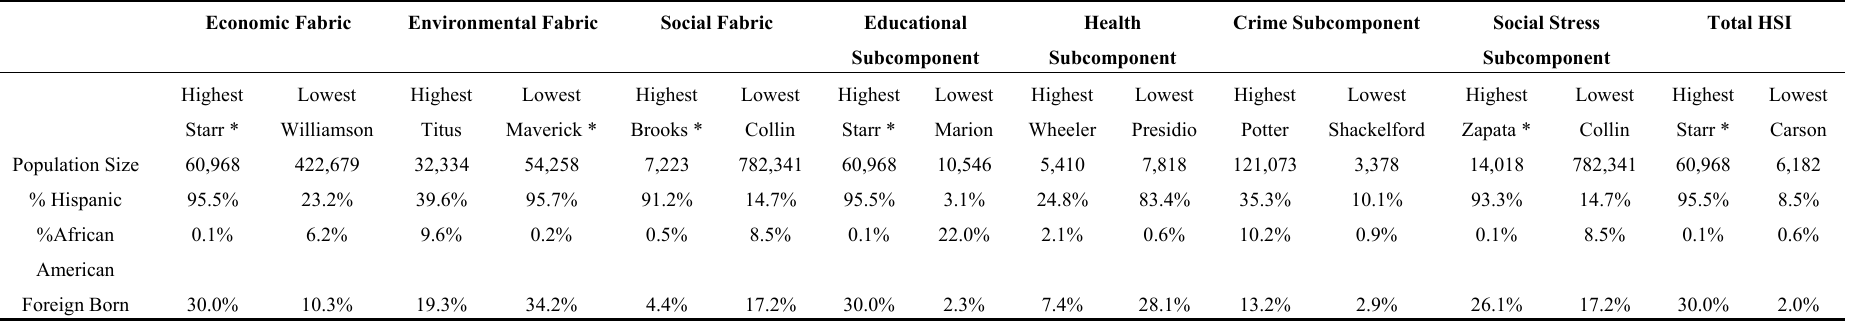
Table A2. Demographic characteristics of highest and lowest scoring by individual fabric, subcomponent and total